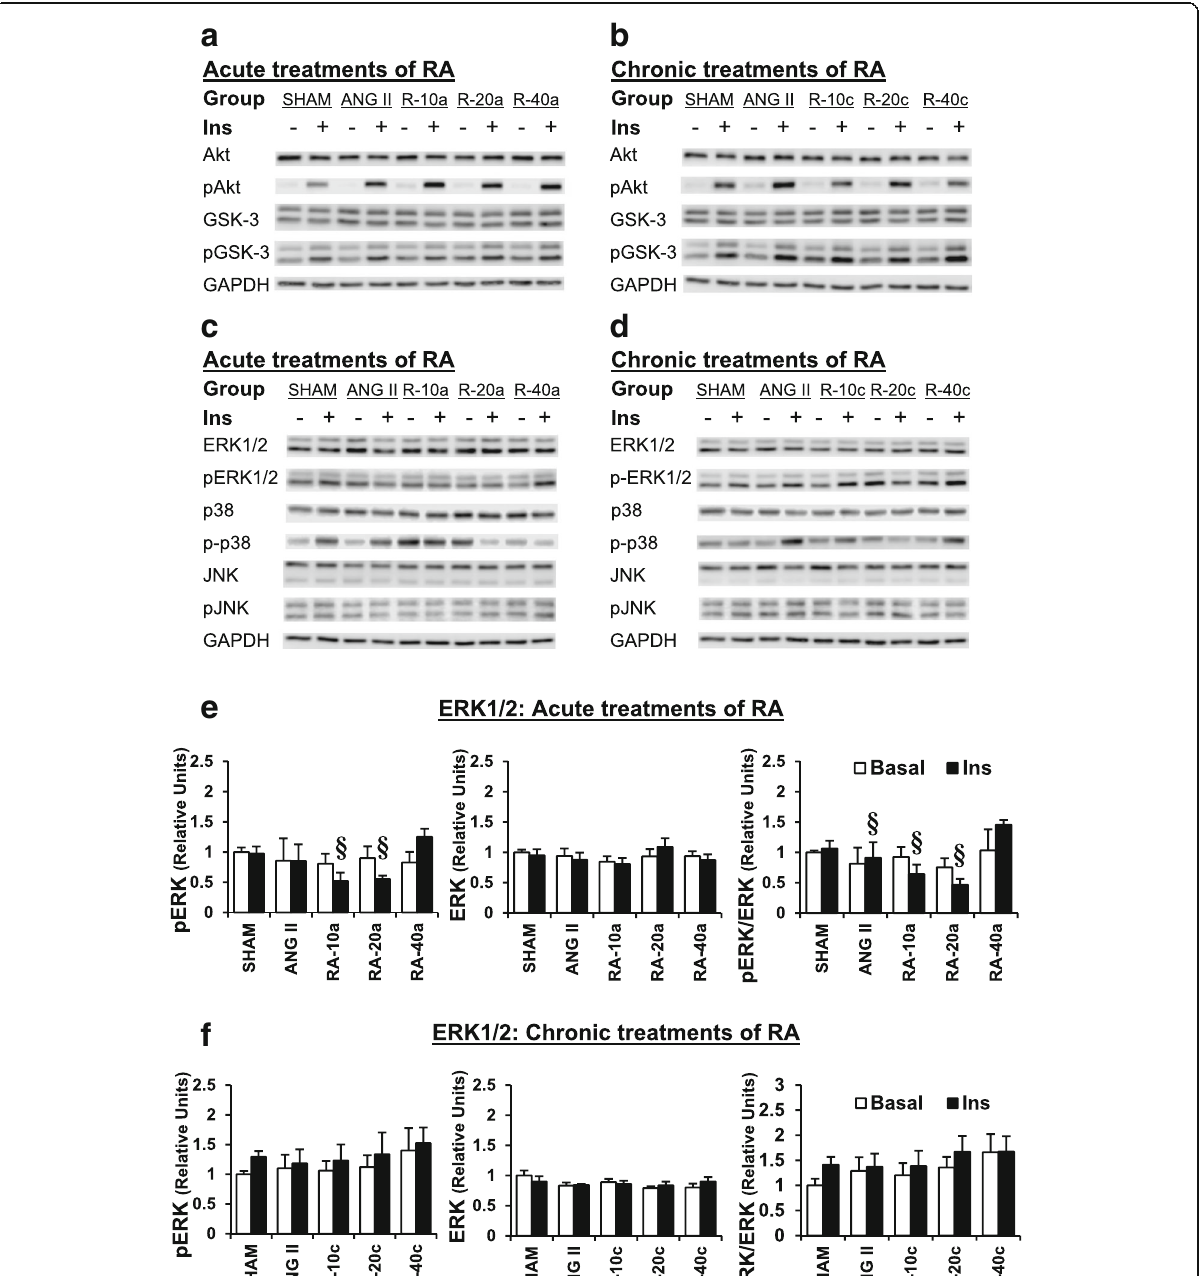
Fig. 3 Western blots of insulin signaling and MAPK signaling after SHAM, ANG II, acute RA (RA-10a, -20a, and -40a mg/kg) ( a , c ), and chronic RA (RA-10c, -20c, and -40c mg/kg) ( b , d ) treatment. ERK1/2 phosphorylation, ERK, and ERK activity after SHAM, ANG II, acute RA (RA-10a, -20a, and -40a mg/kg) ( e ), and chronic RA (RA-10c, -20c, and -40c mg/kg) ( f ) treatment. Values are the mean ± SE. § P < 0.05 vs RA-40a